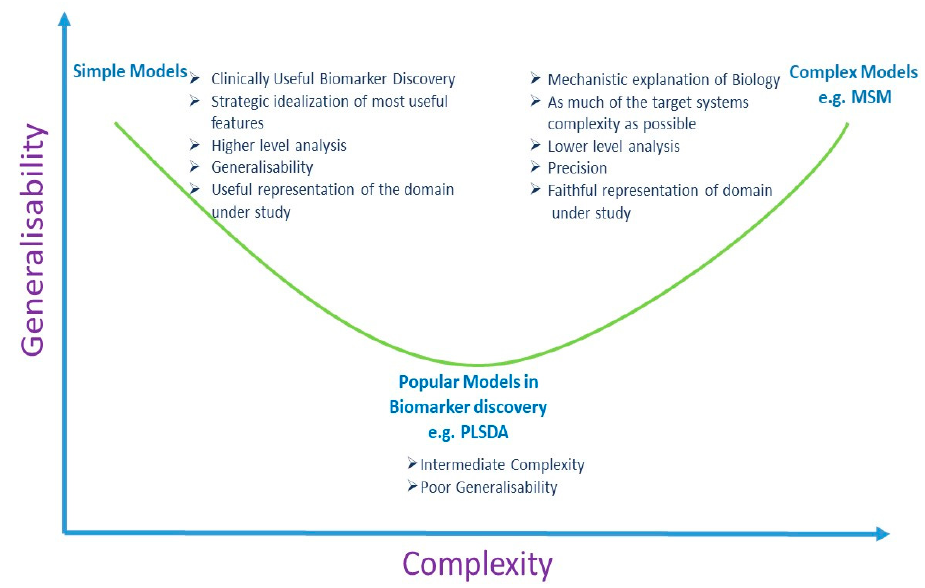
Figure 2. Simple models for biomarker discovery may be more generalisable. (PLSDA: Partial Least Squares Discriminant Analysis; MSM: Multi Scale Mathematical Models).